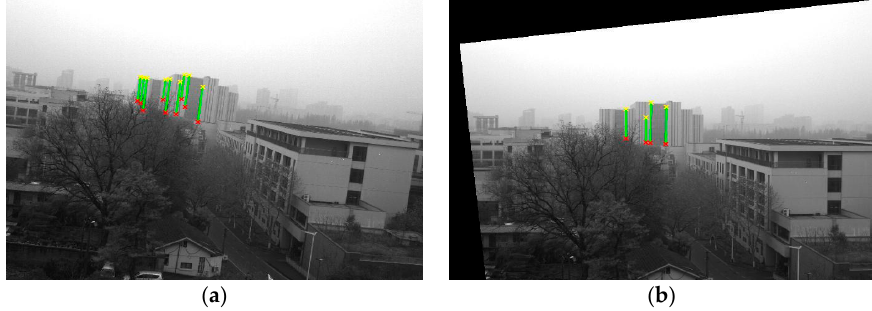
Figure 9. Images with detected plumb lines before and after horizontal correction in System 1. ( a ) The original image I 3 ; ( b ) The horizontally corrected image I 3_ corrected .